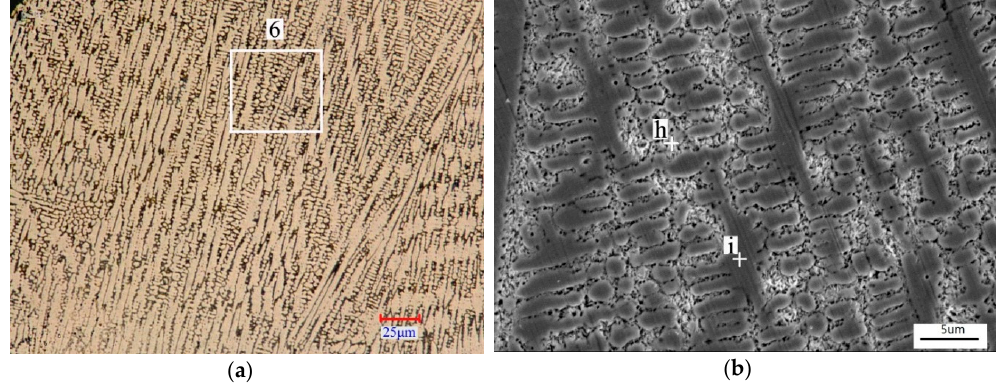
Figure 7. Typical microstructure morphologies of Coating 3: ( a ) OM image of Coating 3; ( b ) Amplification of region 6 in image ( a ).